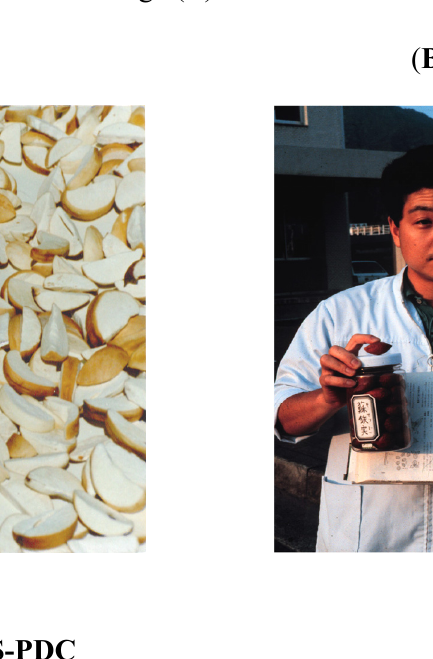
Figure 2. Cut seed of Cycas micronesia , a plant indigenous to Guam and the Micronesian islands, are processed for food by washing the halved or quartered seeds in water and laying them out to dry ( A ). Pharmacist in ALS-PDC focus in Kii Peninsula, Japan holding a labeled bottle of Cycas revoluta seed ( sotetsu ) and a textbook of folk medicine describing pharmaceutical indications for their medicinal usage ( B